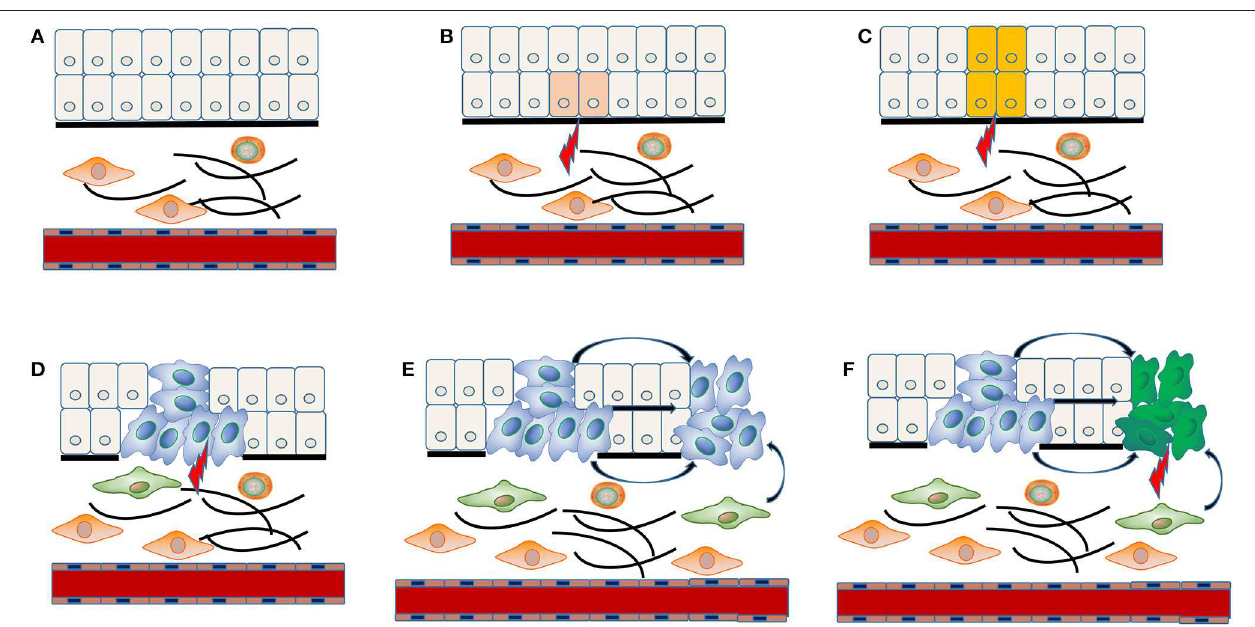
FIGURE 1 | “Field cancerization” theory in the MPCs of HNSCC. The stem cell receives first genetic hit (A) , and gives rise to a patch with genetically altered daughter cells (B) . Then a patch develops into a field by expanding in a lateral direction under the indduction of a second genetic hit (C) . Additional genetic alterations take place and convert the field to an overt carcinoma (D) . The implantation, intraepithelial migration or sub-mucosal spread of primary cancer cells lead to the development of a SPT with monoclonal origin (E) , while the final genetic hit induces the occurrence of a SPT with polyclonal origin (F)